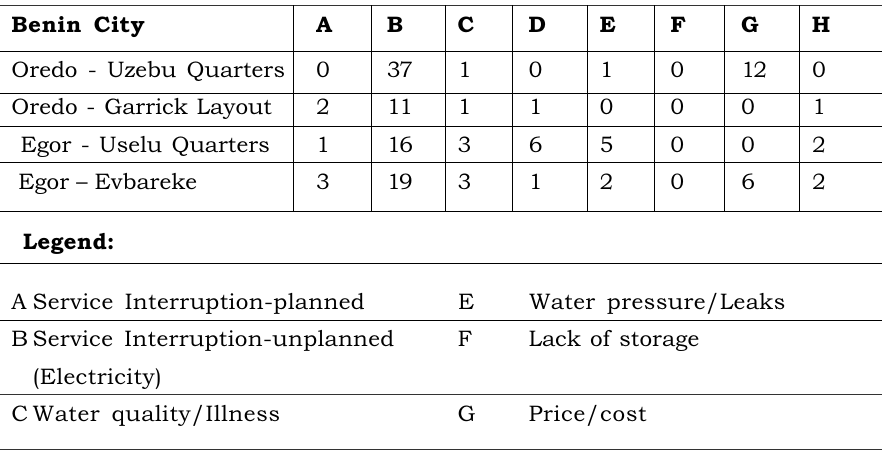
Figure 2. Response to Water Service Delivery